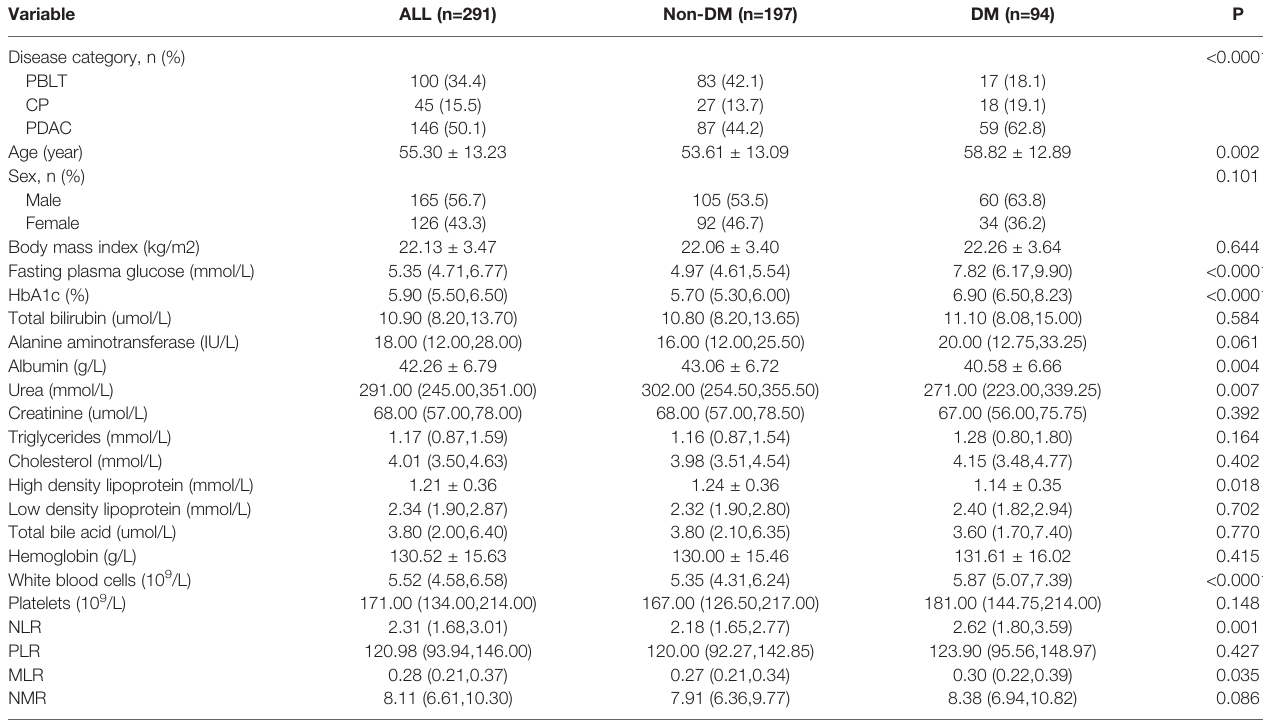
TABLE 1 | Patient characteristics according to diabetes mellitus (DM) status.